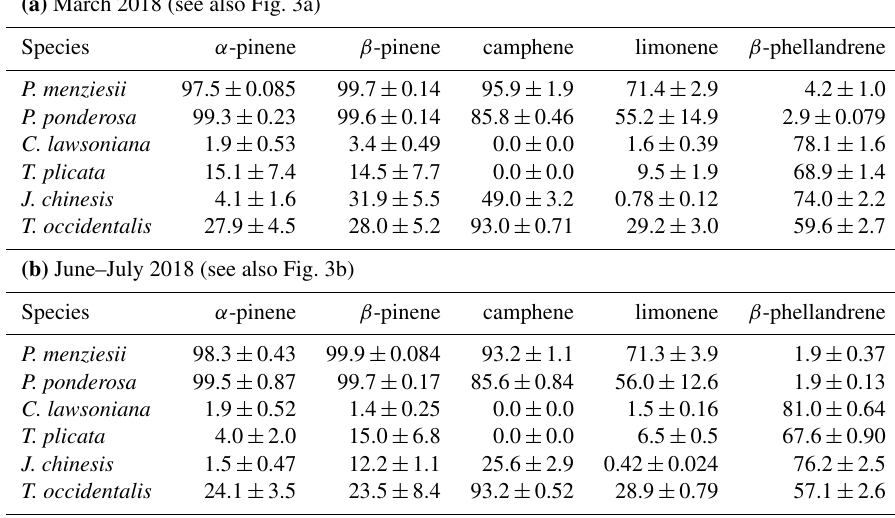
Table 3. Percent ( − )-enantiomer values ± 1 standard deviation (SD) for five chiral monoterpenes in six conifer species in nursery-purchased plants located at PSU sampled in March 2018 and again in June–July 2018. (The data were obtained from the same set of analyses carried out to generate the data in Table 2.)